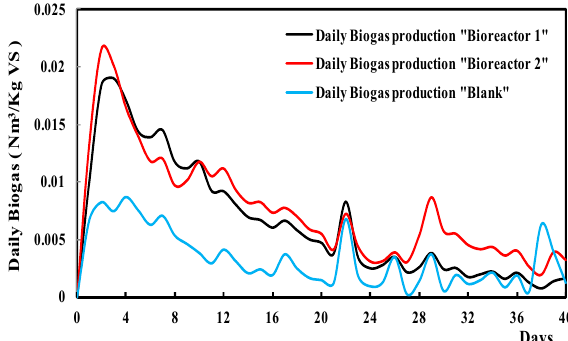
Figure 2. Daily biogas production of the three bioreactors.